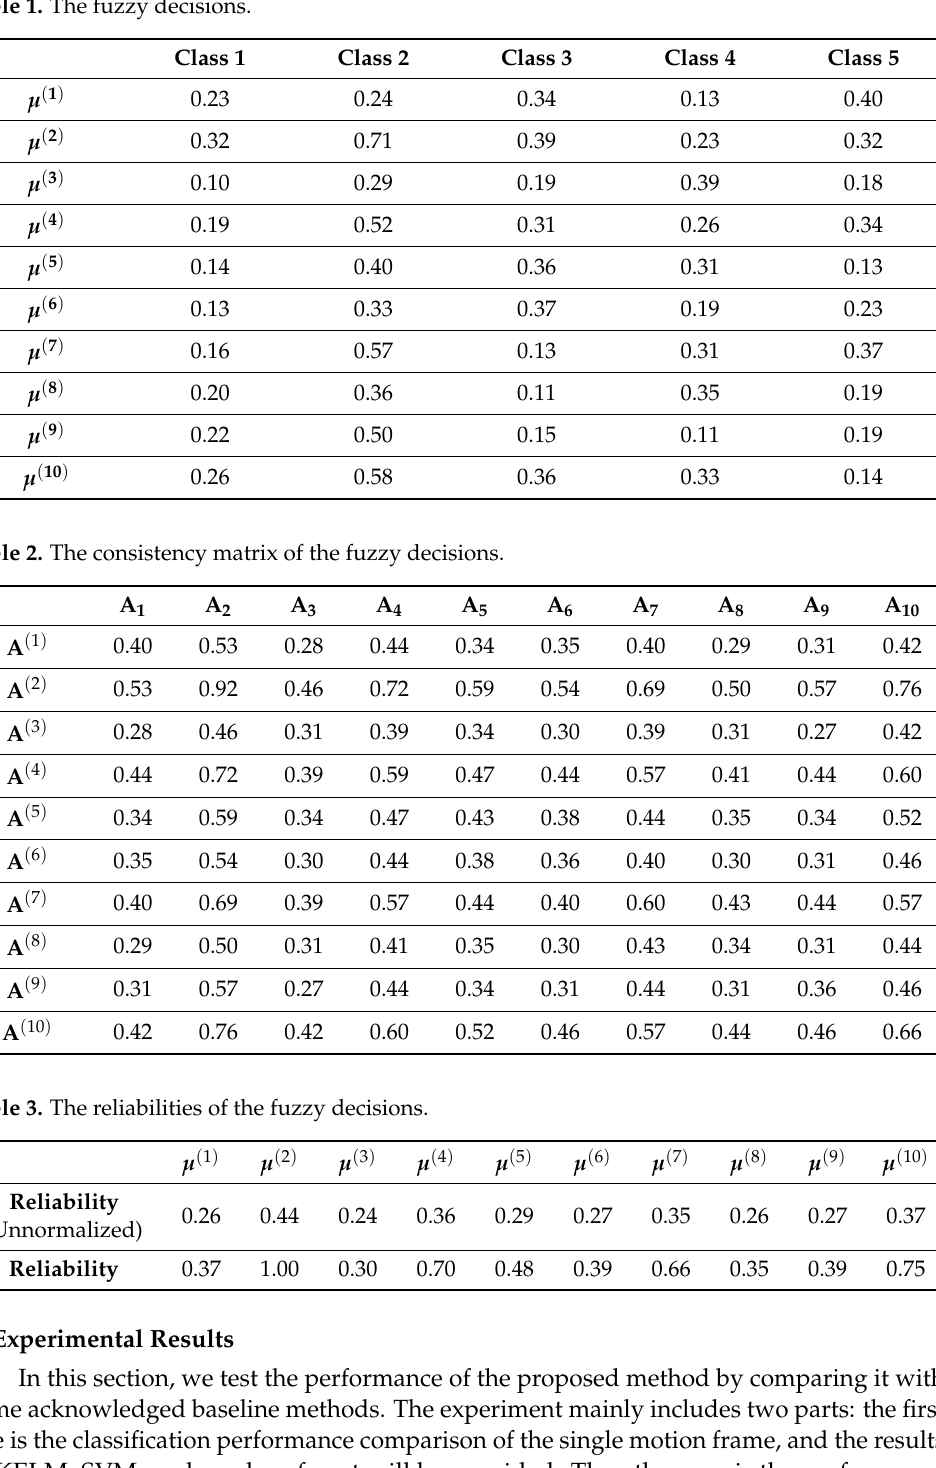
Table 1. The fuzzy decisions.